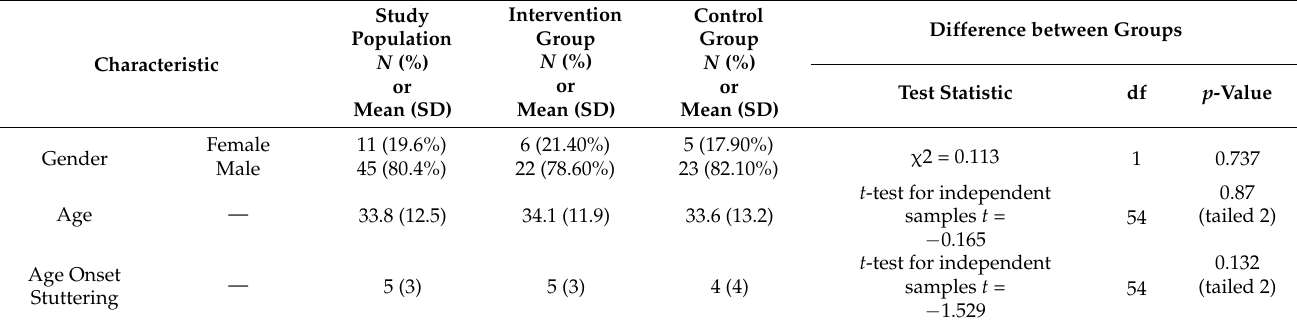
Table 1. Demographic characteristics of the participants ( N = 56).